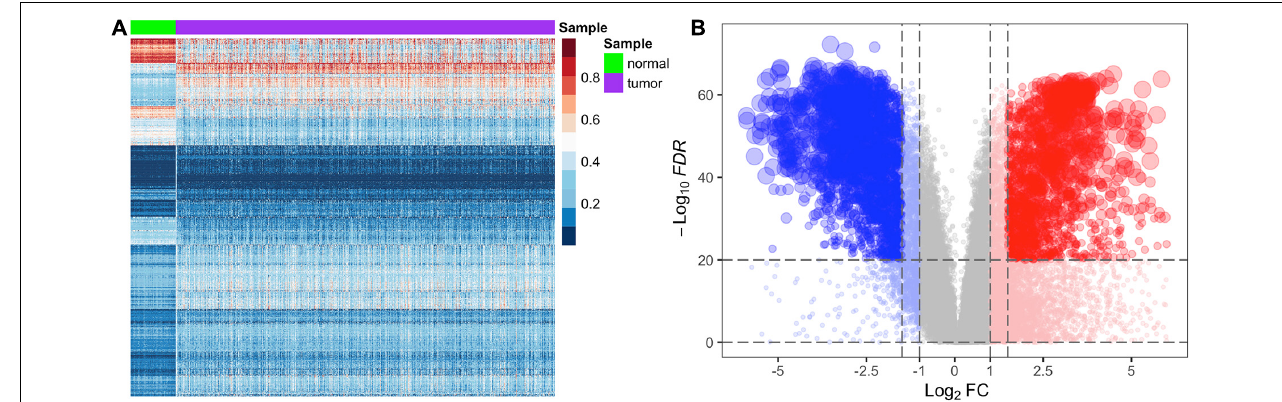
FIGURE 2 | Heatmap analysis of differentially methylated genes and volcano plot analysis of differentially expression genes for the BRCA dataset. In panel (A) , the row represents the methylation level of the genes, and the column represents the normal and tumor samples. Dark red shades indicate the higher level of methylation, and dark blue shades indicate the lower level of methylation. Color keys indicate the intensity associated with normalized beta values. In panel (B) , the x-axis represents the log 2 FC , and the y-axis represents − log 10 ( FDR ) , and each dot represents a gene. The significantly upregulated genes are highlighted in red, and the significantly downregulated genes in